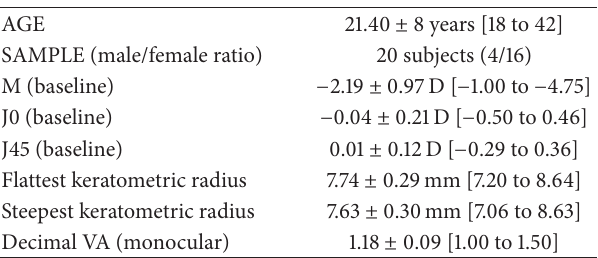
Table 1: Demographic, refractive, and keratometric data of subjects (mean ± SD) and range [minimum and